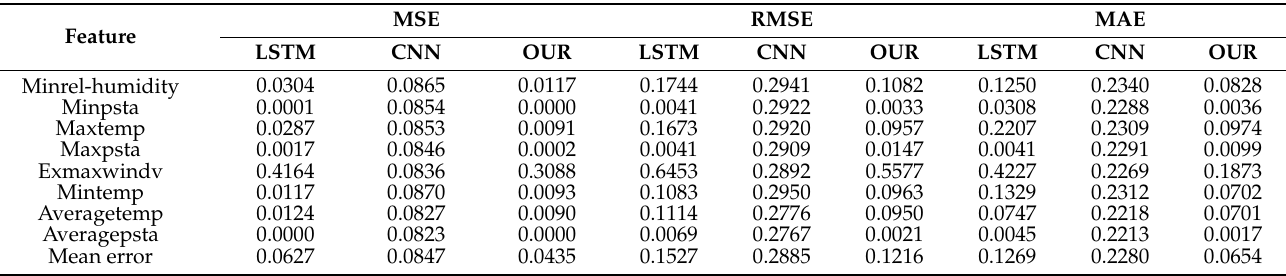
Table 3. Error comparison results of deep learning